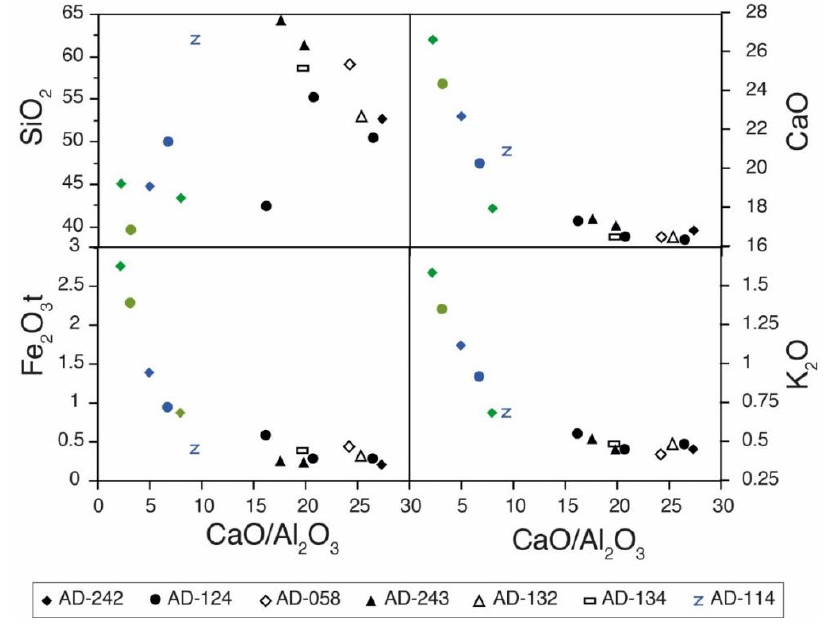
Figure 6. Binary diagrams of CaO / Al 2 O 3 versus SiO 2 , CaO, Fe 2 O 3 and K 2 O oxides plotting the chemical composition of Arroyo de la Dehesa de Velasco site mortar layers. Green symbols correspond to layers with ceramic fragments. Blue symbols correspond to clay-rich scratch coat layers from plasters and to sandy-clayey floor mortar.